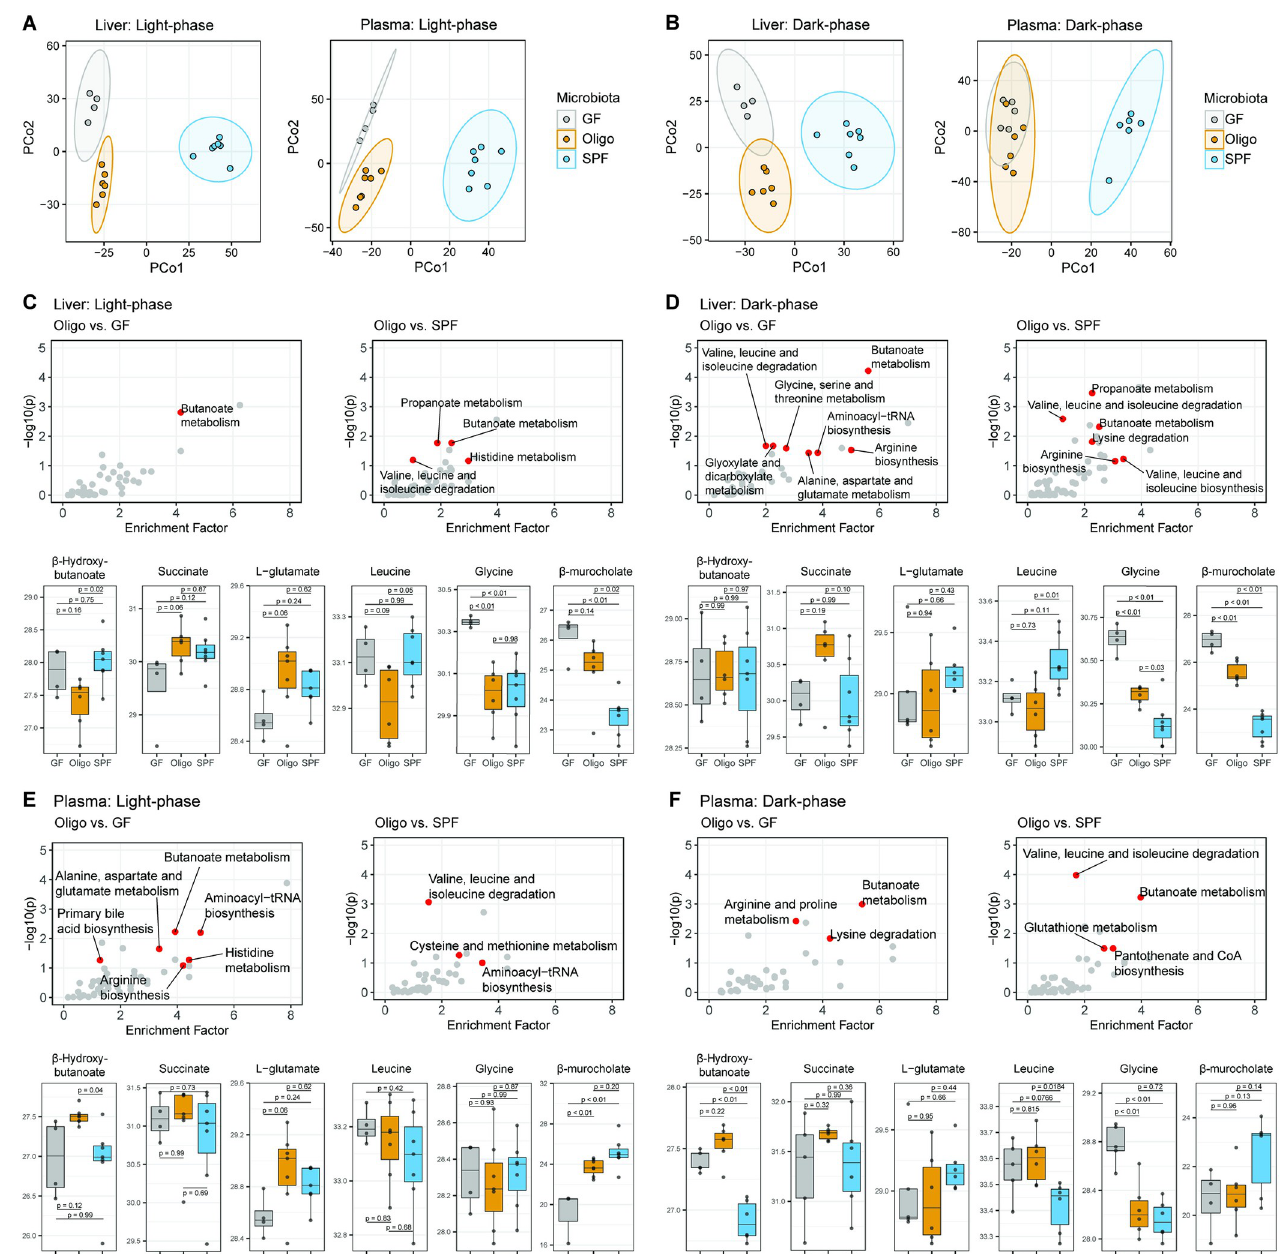
Fig 4. Metabolic profile comparison of GF, OligoMM12, and SPF C57B6/J mice by UPLC/MS. (A and B) Principal coordinate analysis using Canberra distances of metabolites identified by untargeted UPLC/MS in liver and plasma during the (A) light phase (Zeitgeber 5) and (B) dark phase (Zeitgeber 16). (C-F) Metabolic pathways identified in the KEGG PATHWAY database; red dots represent pathways containing compounds differentially enriched in OligoMM12 vs.GF and OligoMM12 vs. SPF comparisons and selected compounds obtained by targeted peak extraction from differentially expressed pathways. Samples obtained during the light phase (Zeitgeber 5) and dark phase (Zeitgeber 16) in (C and D) liver and (E and F) plasma. p -values obtained by Tukey’s honest significance test after log 2 transformation of area value. Number of mice per group: Liver ZT5: GF = 4, OligoMM12 = 6, SPF = 7; ZT16: GF = 4, OligoMM12 = 6, SPF = 7 / Plasma ZT5: GF = 4, OligoMM12 = 7, SPF = 7; ZT16: GF = 5, OligoMM12 = 6, SPF = 6. Data underlying this figure are supplied in S1 Data. GF, germ-free; SPF, specific-opportunistic-pathogen-free; UPLC/MS, ultraperformance liquid chromatography coupled with mass spectrometry; ZT, Zeitgeber time.